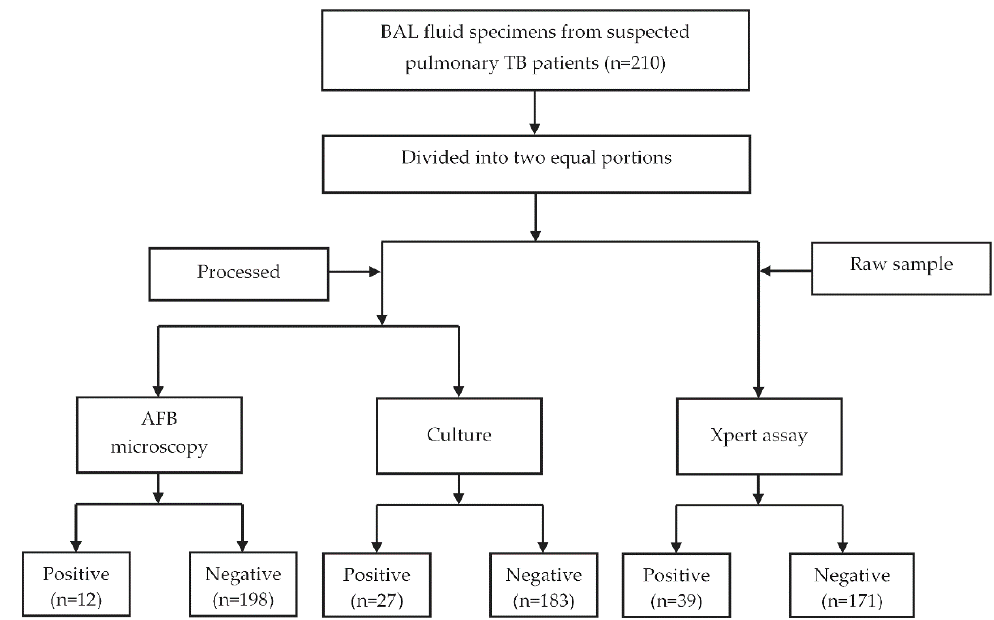
Figure 1. Study flowchart explaining the patient enrolment, methodology, and test results.